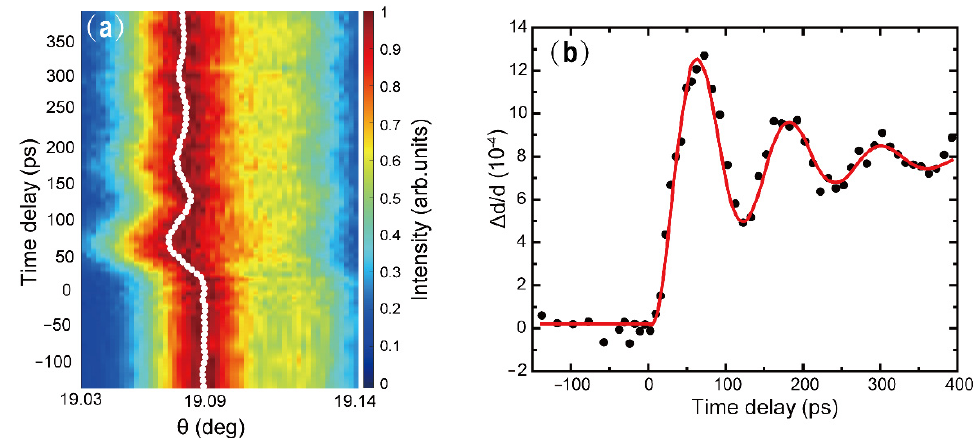
Figure 3. ( a ) Transient θ –2 θ scans for different delay times of − 140 ps < t < 390 ps. The white dotted line indicates the center of the Bragg peaks. ( b ) Variation of inter-atomic spacing of a 200-nm Au (111) crystal as a function of pump-probe time delay. The fitting by a sine-damping function is shown as a solid red line.